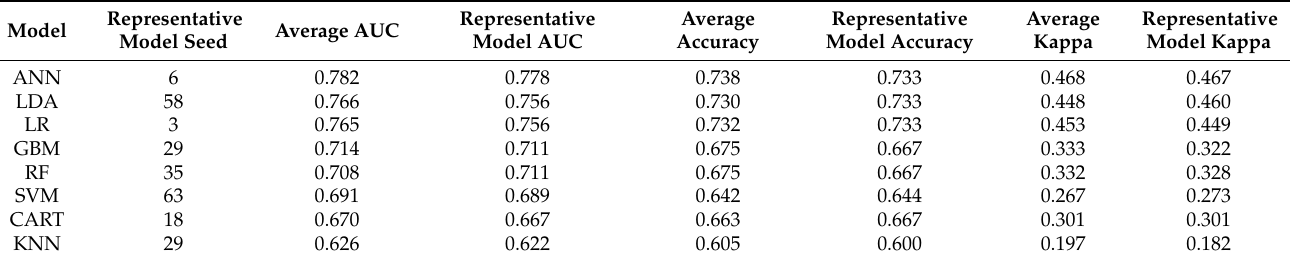
Table 5. Comparison of averaged model scores and representative model scores based on the chosen seed values.